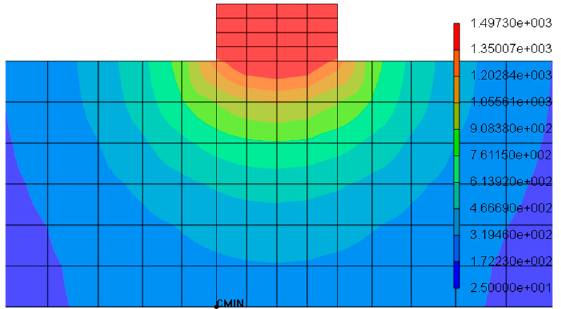
Figure 9. Gaussian heat distribution and melt pool con fi guration in complete layer consolidation.